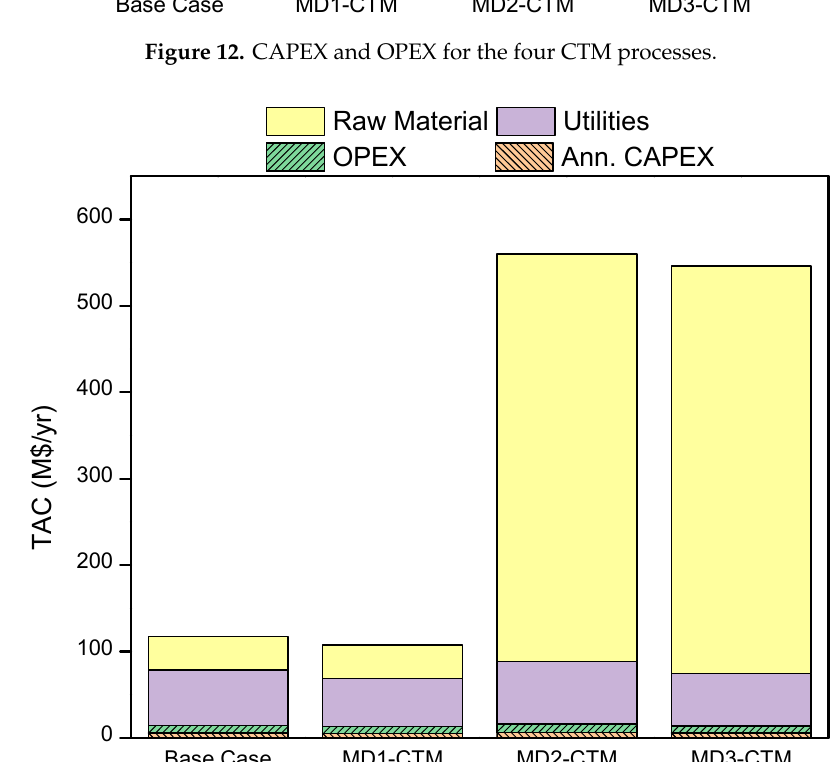
Figure 13. Total annual cost (TAC) for the four CTM processes.